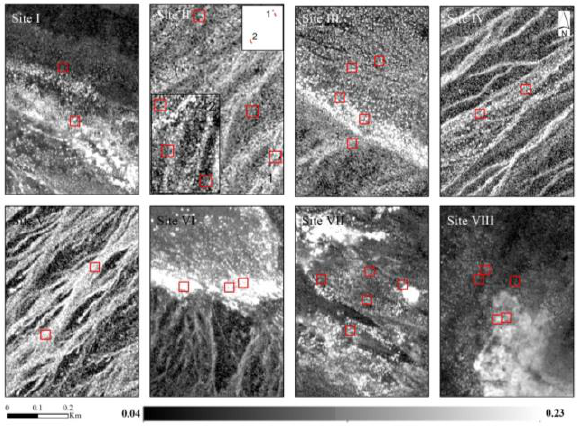
Figure 4. The MSAVI of Pleiades-1 (2 m) as shown vegetation cover of eight sites. The images were acquired between July and September 2017. Shrub covers are shown by white colours with the borderline of the plot area by the red curve in the figure.